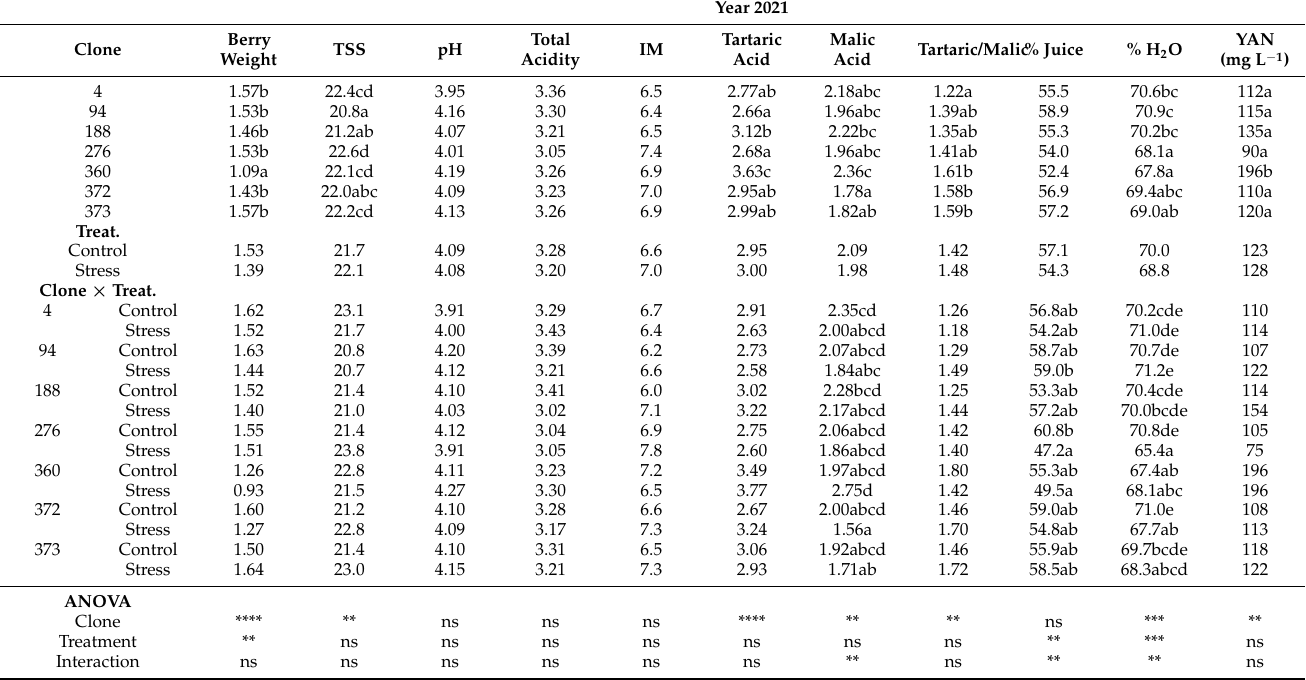
Table 10. Average annual values of berry technological quality at harvest for each clone, irrigation treatment, and the interaction (clone × irrigation treatment) during year 2021. TSS (total soluble solids, ◦ Brix), titratable acidity (g tartaric acid L − 1 ), IM (maturity index, ◦ Brix/ Titratable acidity), tartaric acid (g L − 1 ), and malic acid (g L − 1 ), YAN (yeast available